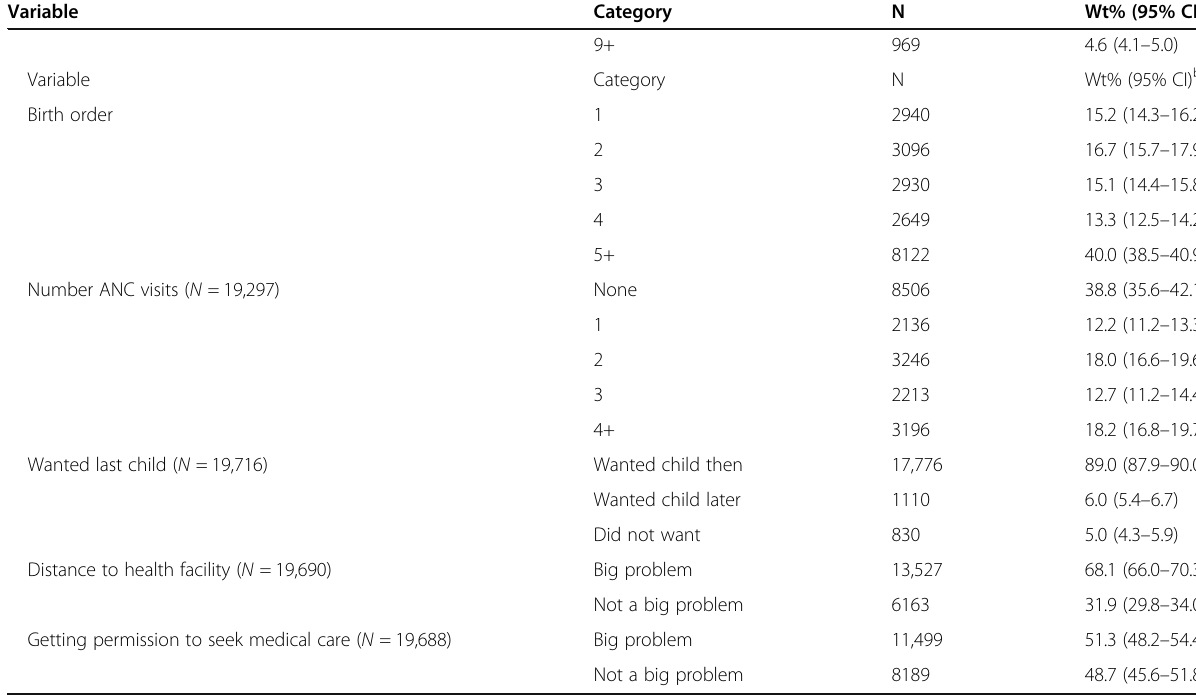
Table 1 Baseline characteristics of women ages 15 – 49 a , Afghanistan Demographic and Health Survey 2015 (Continued)